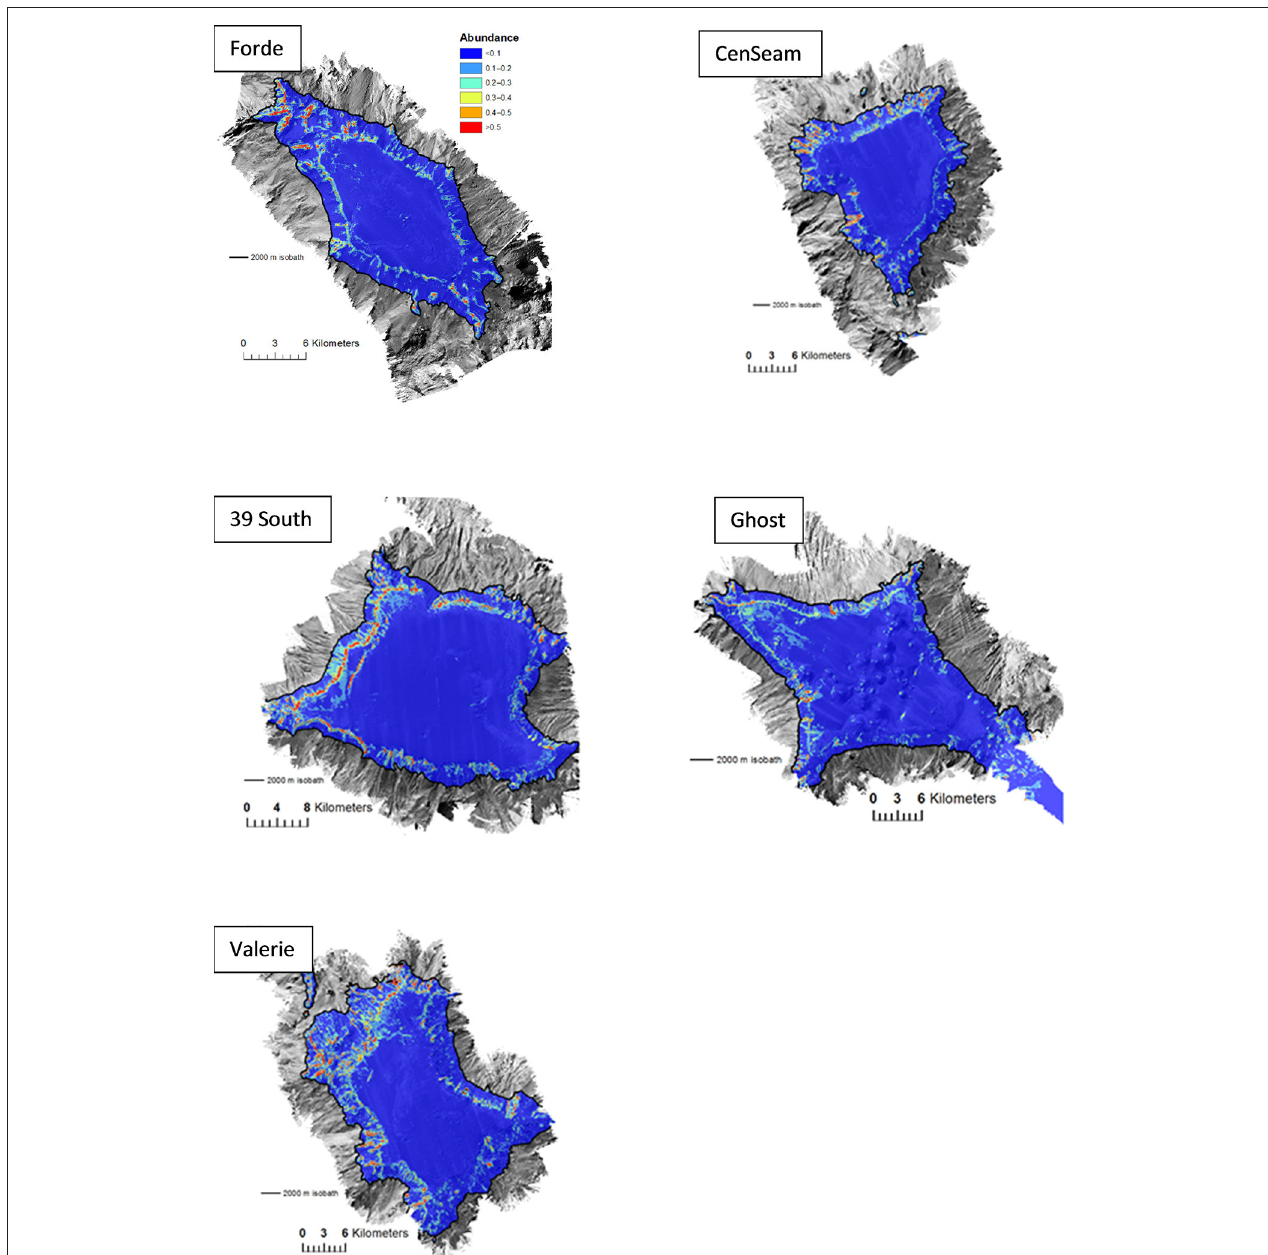
FIGURE 5 | Predictions of Solenosmilia variabilis abundance (number of “live head” colonies per 25 × 25m model cell) for ensemble habitat suitability model. Color-coded model abundance estimates are draped over the MBES bathymetry obtained during the